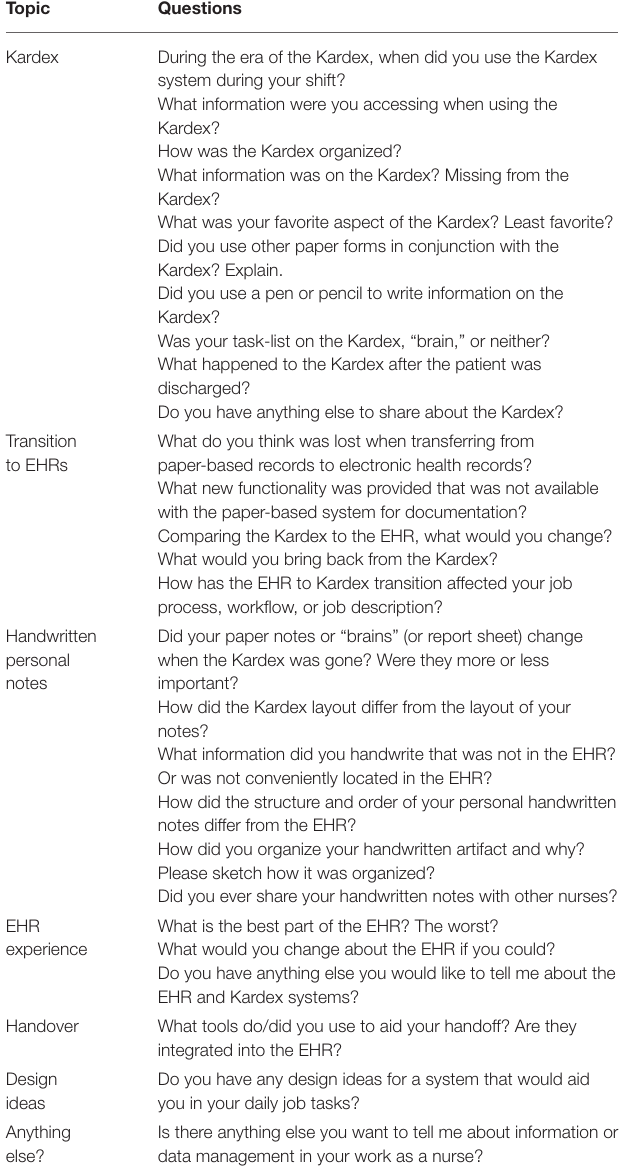
TABLE 1 | Semi-structured interview topics and questions. Topic